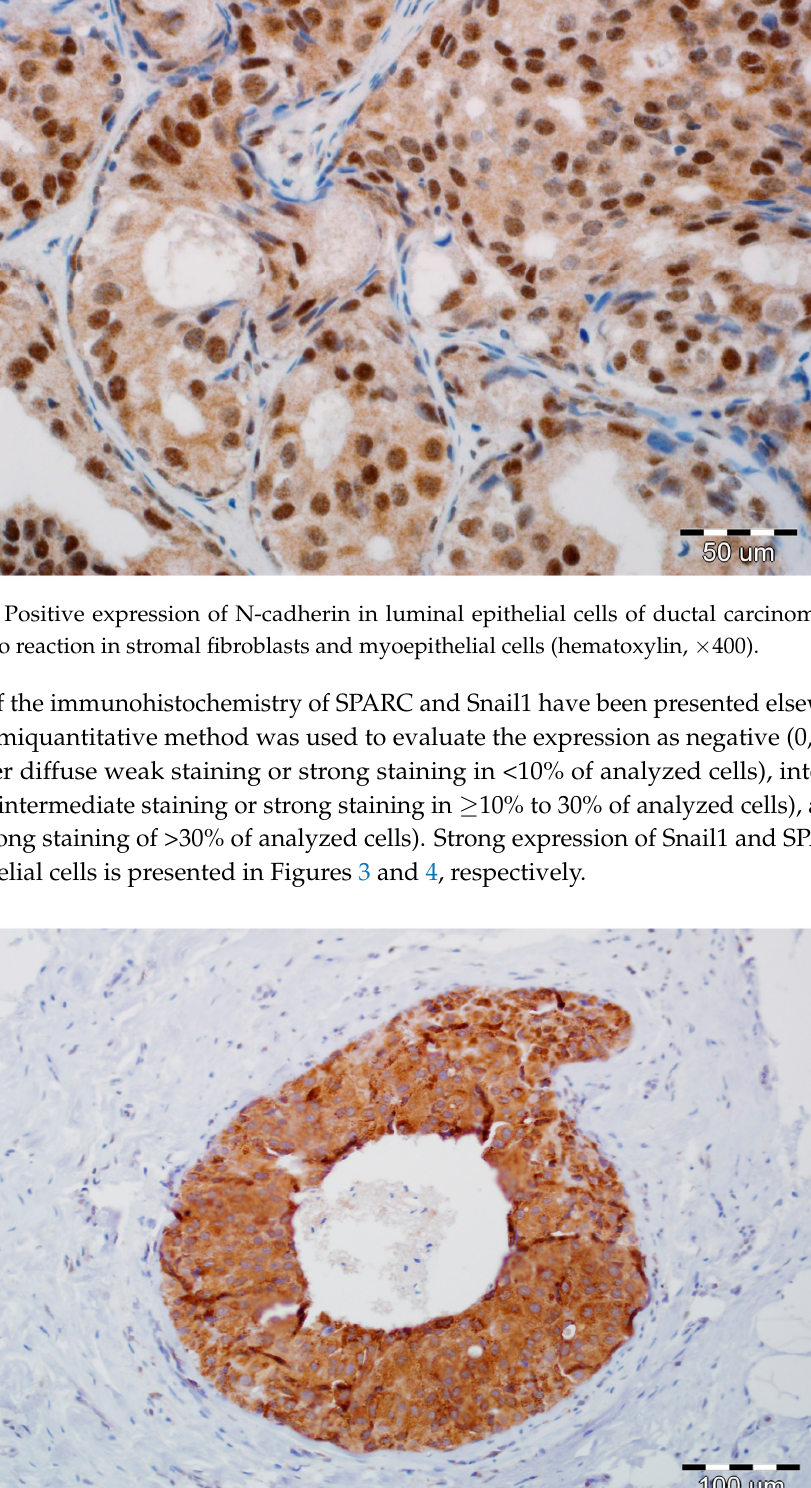
Figure 3. Strong expression of Snail1 in DCIS luminal epithelial cells and lack of its reactivity in myoepithelial cells and stromal fibroblasts (hematoxylin, ×200).